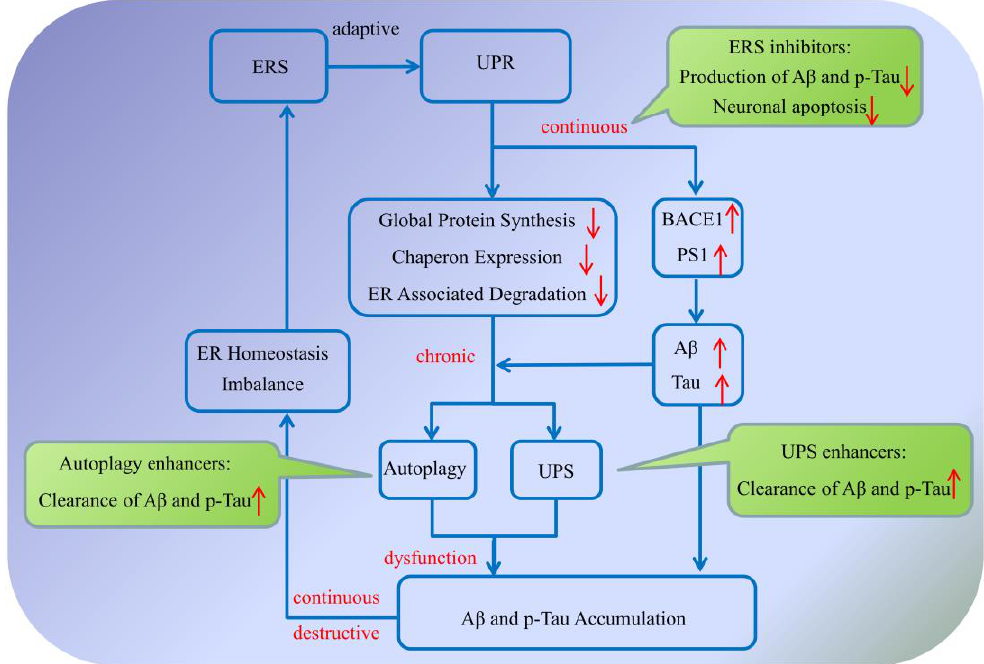
Figure 5. Related mechanisms and molecular targets between protein quality control system and Alzheimer ’ s disease. Aβ: amyloid - β protein; BACE1: β -amyloid precursor protein cleaving enzyme 1; ER: endoplasmic reticulum; PS1: presenilin 1; p-Tau: hyperphosphorylated Tau; UPR: unfolded protein response; UPS: ubiquitin-proteasome system. The upward red arrow indicates up-regulation of expression, while the downward red arrow indicates downregulation of expression. The blue V arrow indicates the activation of process.